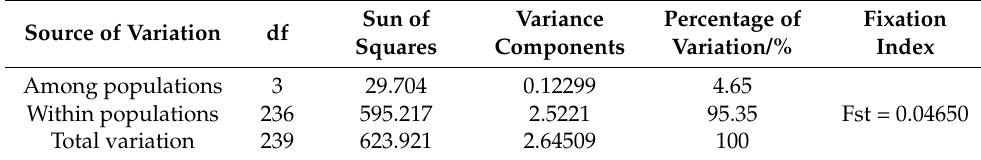
Table 7. Molecular variance (AMOVA) results of four H. molitrix populations.